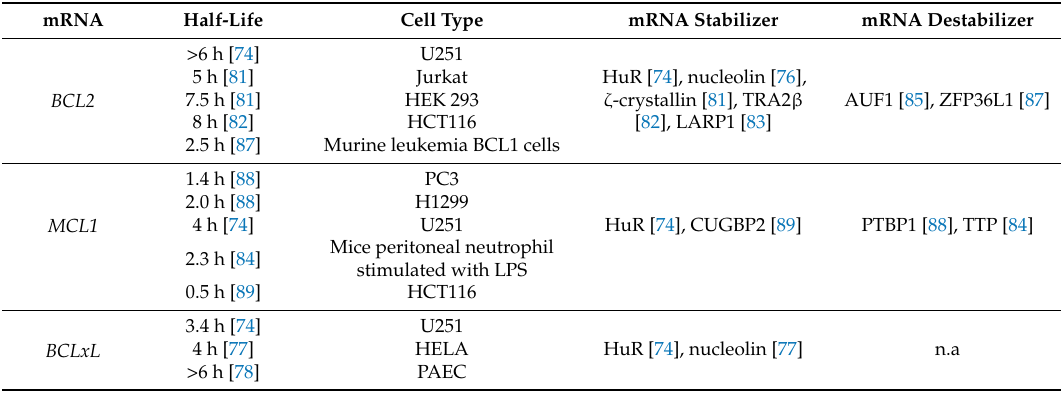
Table 2. A summary of BCL2 , MCL1 , and BCLxL mRNA half-lives in different cell lines and their mRNA stabilizers and